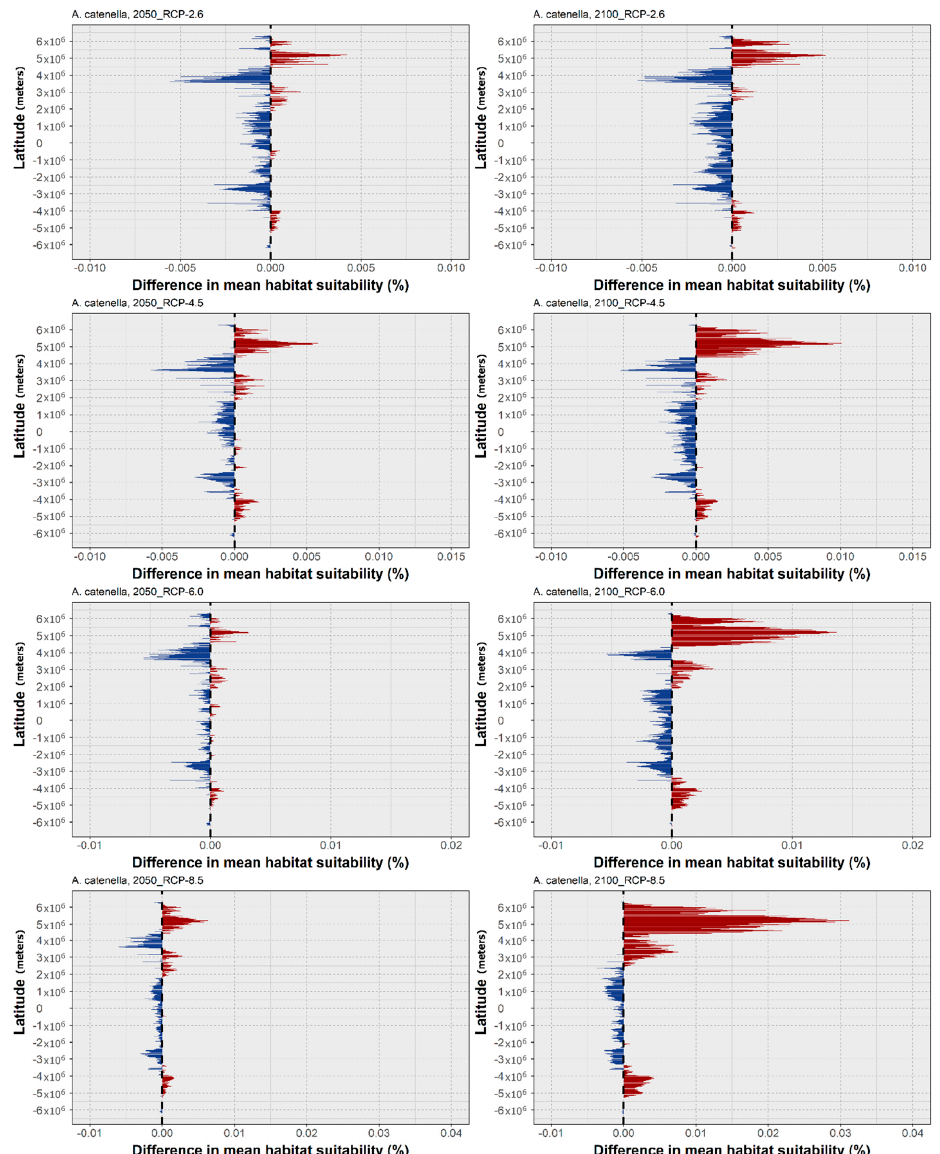
Figure 2. Projected changes in mean latitudinal habitat suitability for A. catenella between the present-day and 2050 ( left side ) and 2100 ( right side ), for each Representative Concentration Pathway scenario (RCP-2.6, 4.5, 6.0, 8.5; CMIP5), relative to the present-day baseline (i.e., the black dashed vertical line). Data to the right of the dashed line represents gains (red) and data to the left represents losses in mean habitat suitability (blue).